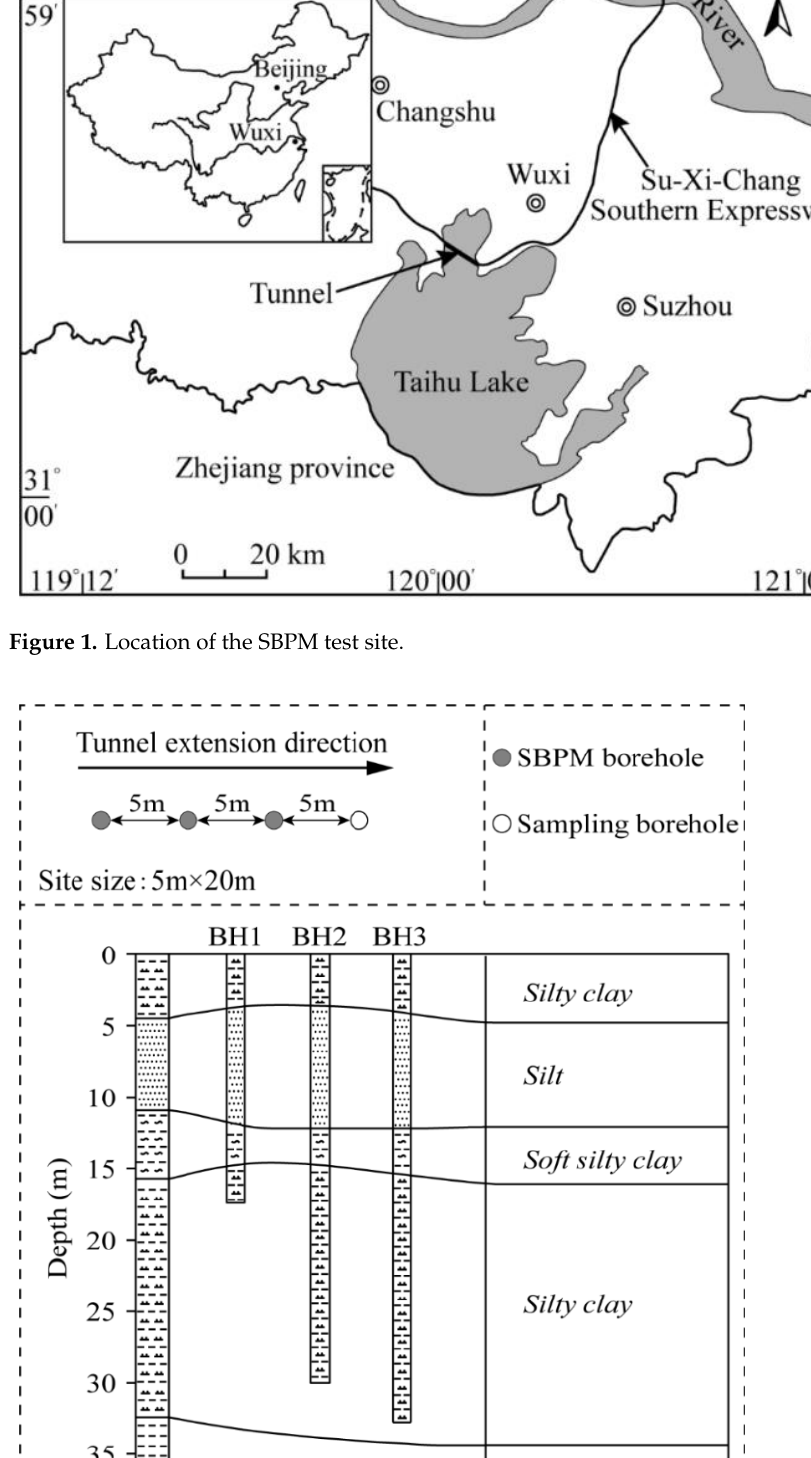
Figure 1. Location of the SBPM test site.